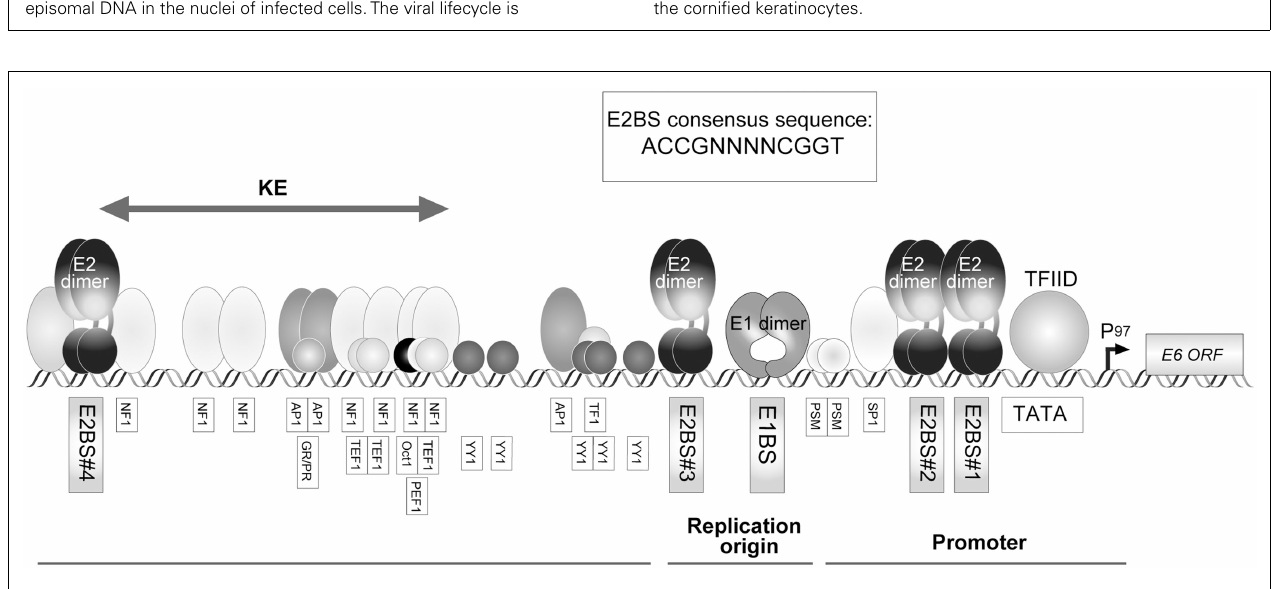
strictly controlled by host cell differentiation, and the late lifecycle (productive lifecycle) occurs in upper layers of the epithelia that are terminally differentiated, and the progenitor virions are released from the cornified keratinocytes.